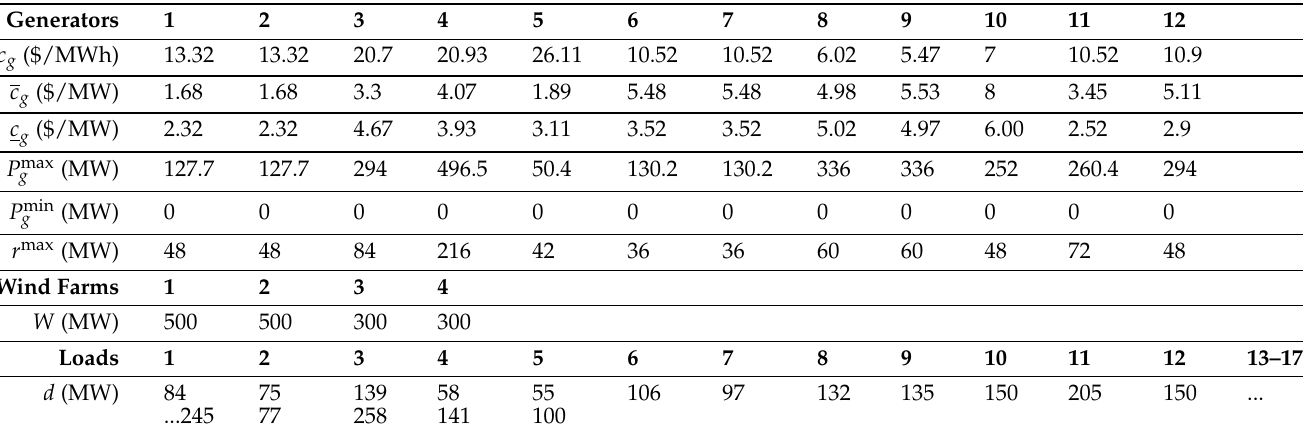
Figure 2. DA-Energy and Reserve Dispatch problem—Adapted IEEE 24-node reliability test system. Table 1. Network